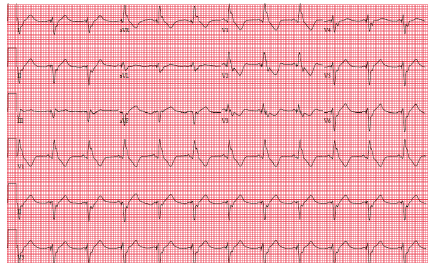
Figure 1: A 12-lead electrocardiogram (ECG) showing (right bundle-branch block RBBB) morphology.